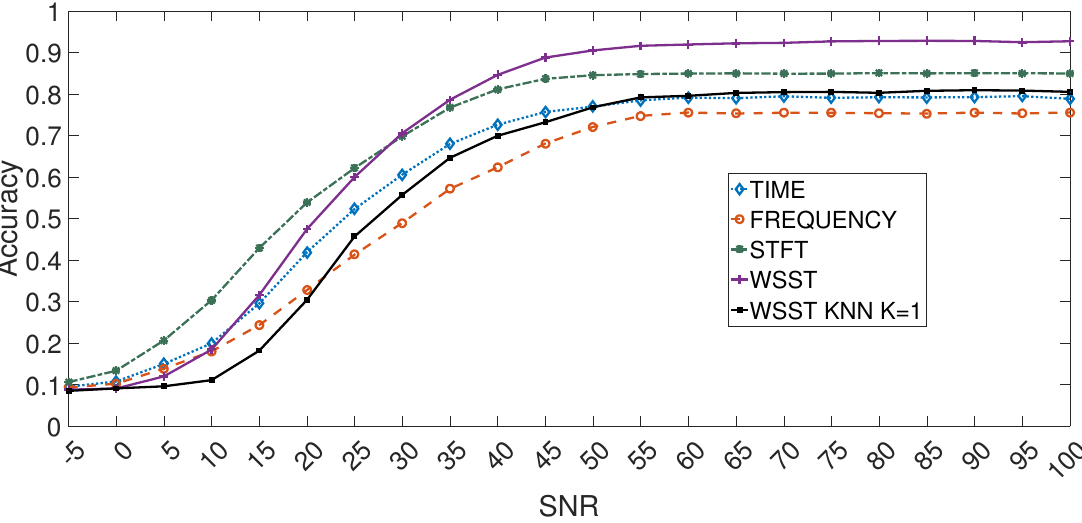
Figure 8. Accuracy for different values of SNR (expressed in dB) for 1D TD, 1D FD, 2D STFT and 2D WSST using the optimal selection of hyperparameters defined in Table 2. The black line is inserted to show the comparison with the application of the WSST technique with KNN (K = 1).